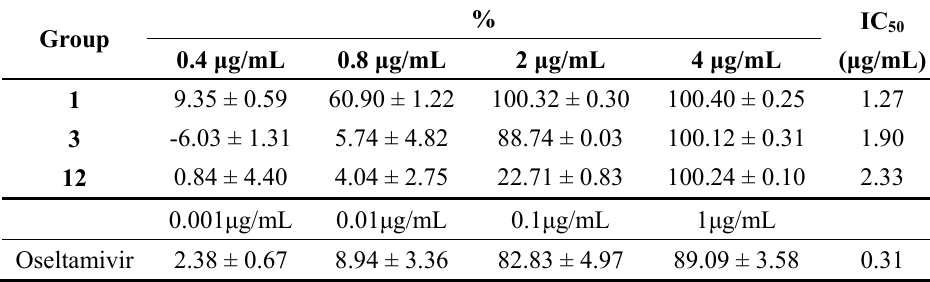
Table 3. Anti NA activity of compounds 1 , 3 and